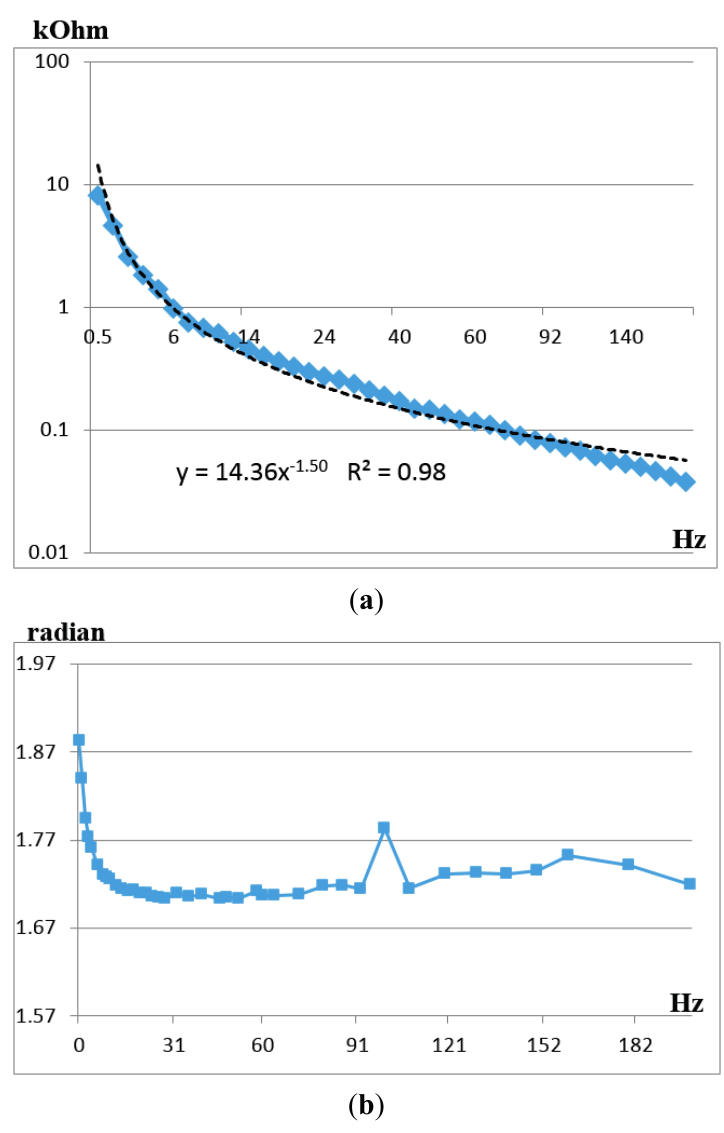
Figure 9. ( а ) Experimental impedance module of molecular electronic angular motion sensor in kilohms; ( b ) Experimental impedance phase of molecular electronic angular motion sensor in radians. The X-axis is the frequency in